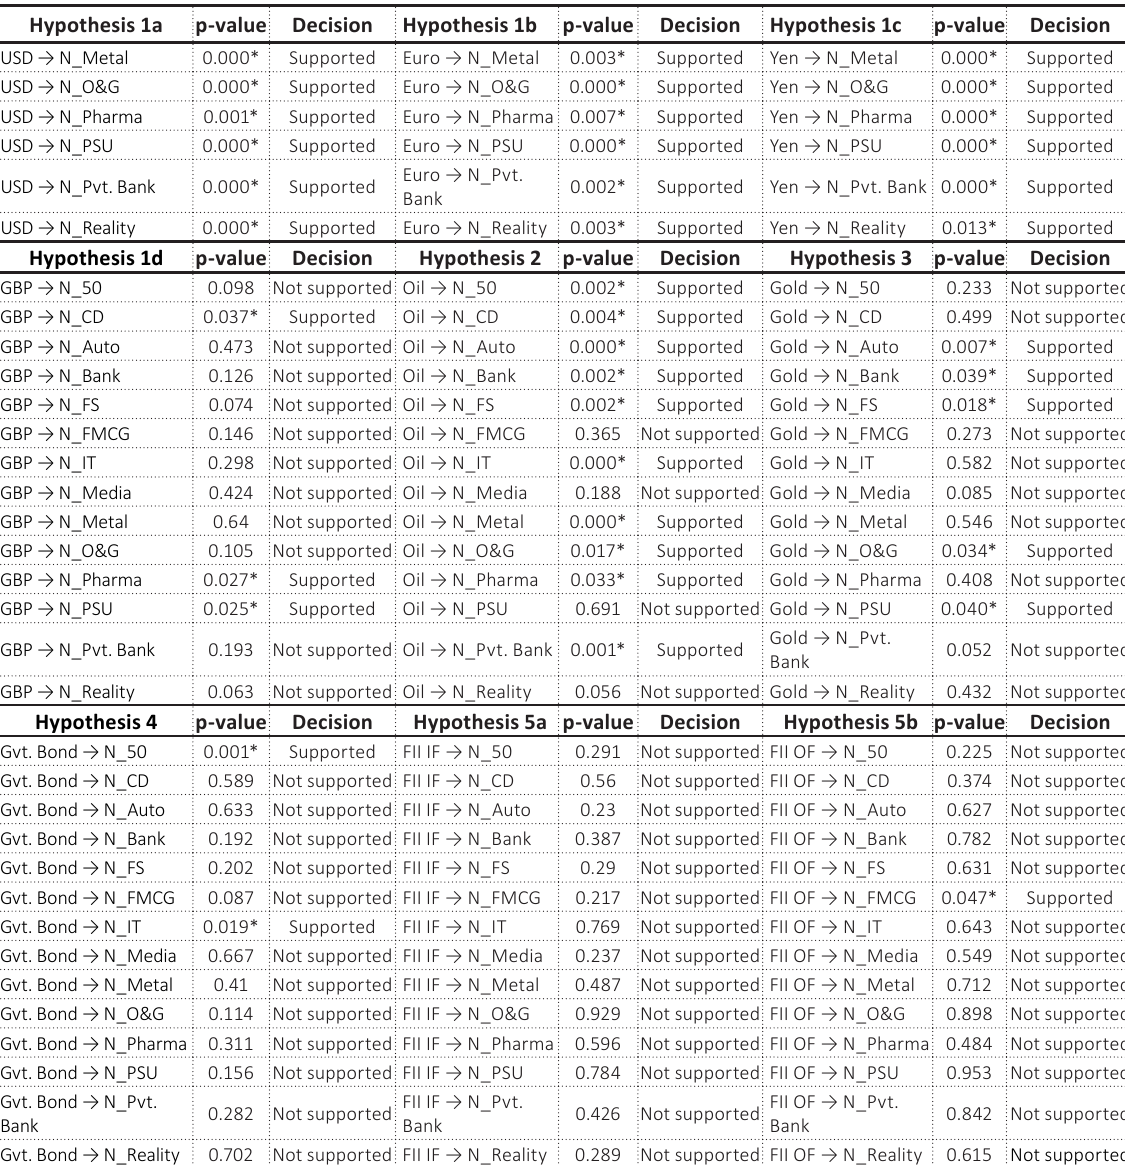
Table 4 (cont.). Summary of hypothesis testing